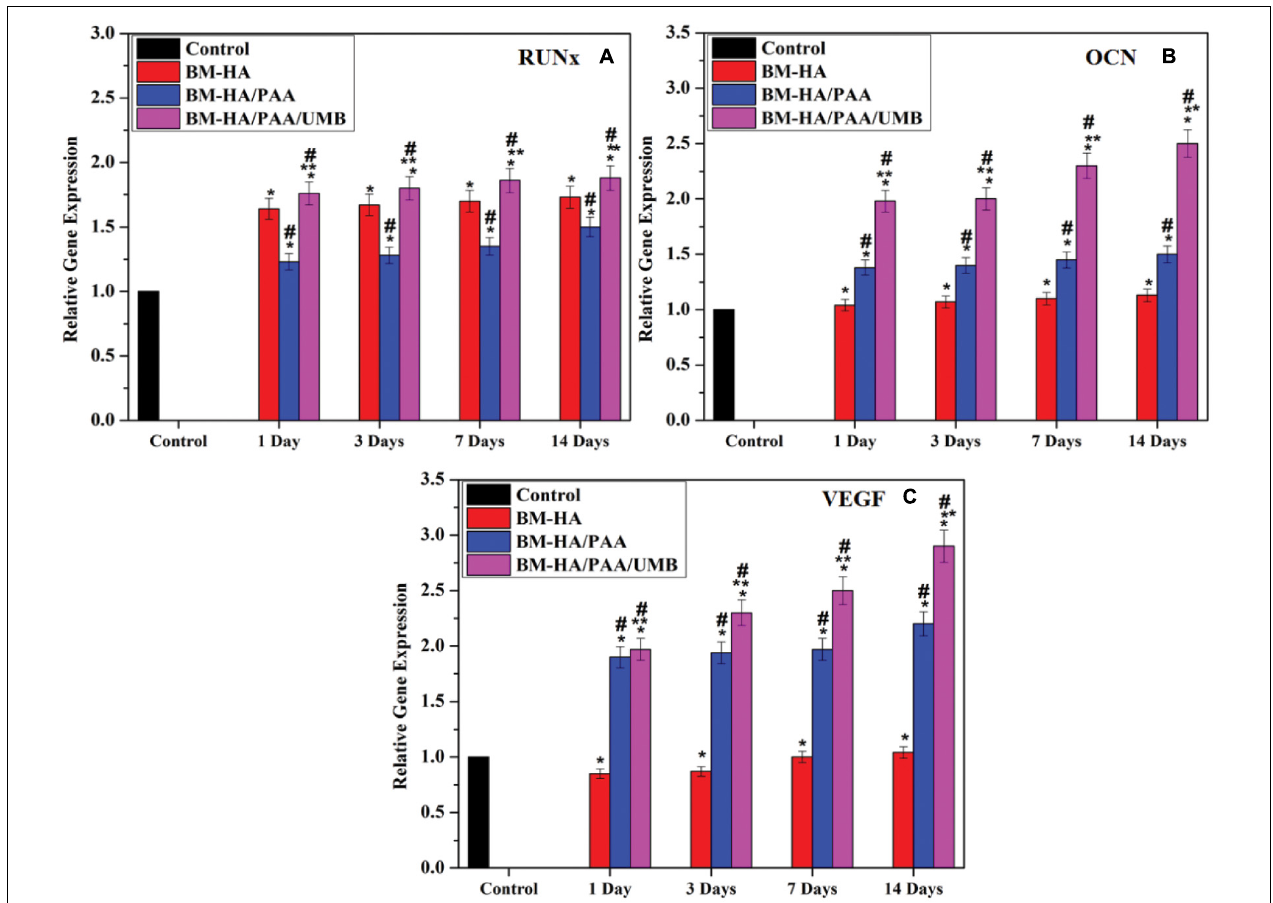
FIGURE 8 | Specific osteogenic differentiation markers (A) Runx2, (B) OCN, and (C) VEGF were assayed by qRT-PCR analysis. *Comparison of the indicated group with control cells within the same set; p < 0.05. # Comparison of the indicated group with the BM-HA composite within the same set; p < 0.05. **Comparison of the indicated group with the BM-HA/PAA composite within the same set; p <